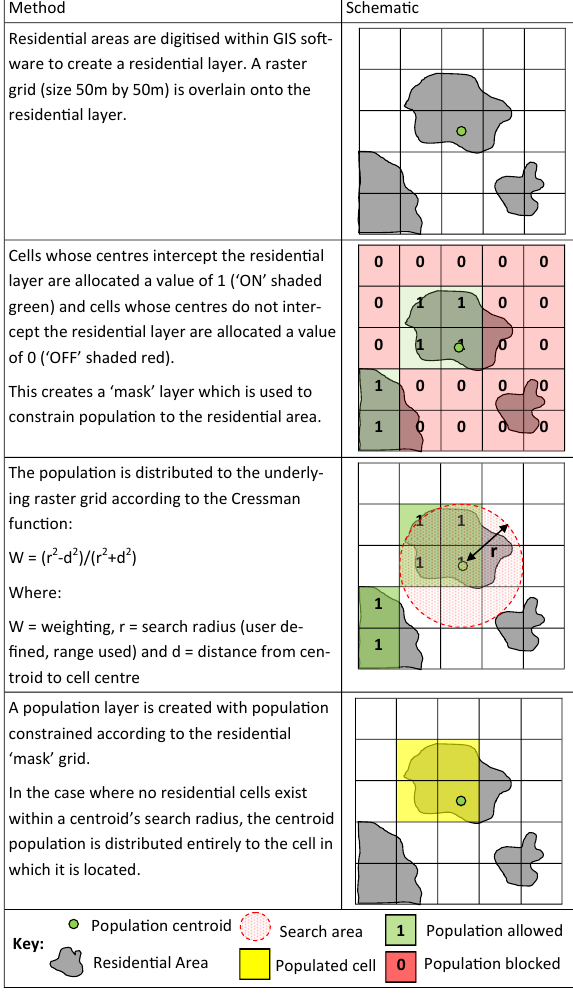
Figure A1. Population spreading method used in this study. See Martin (1989) and Bracken and Martin (1989) for further informa- tion on the centroid distribution